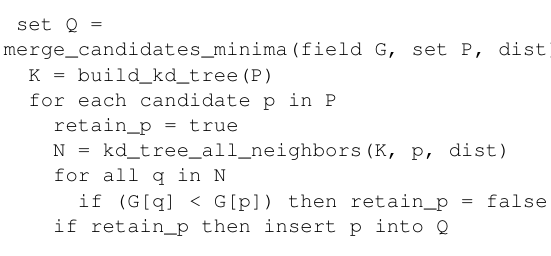
Algorithm 3 Given a field G defined on an unstructured grid and a set of candidate points P , remove candidate minima that are within a distance dist of a more extreme